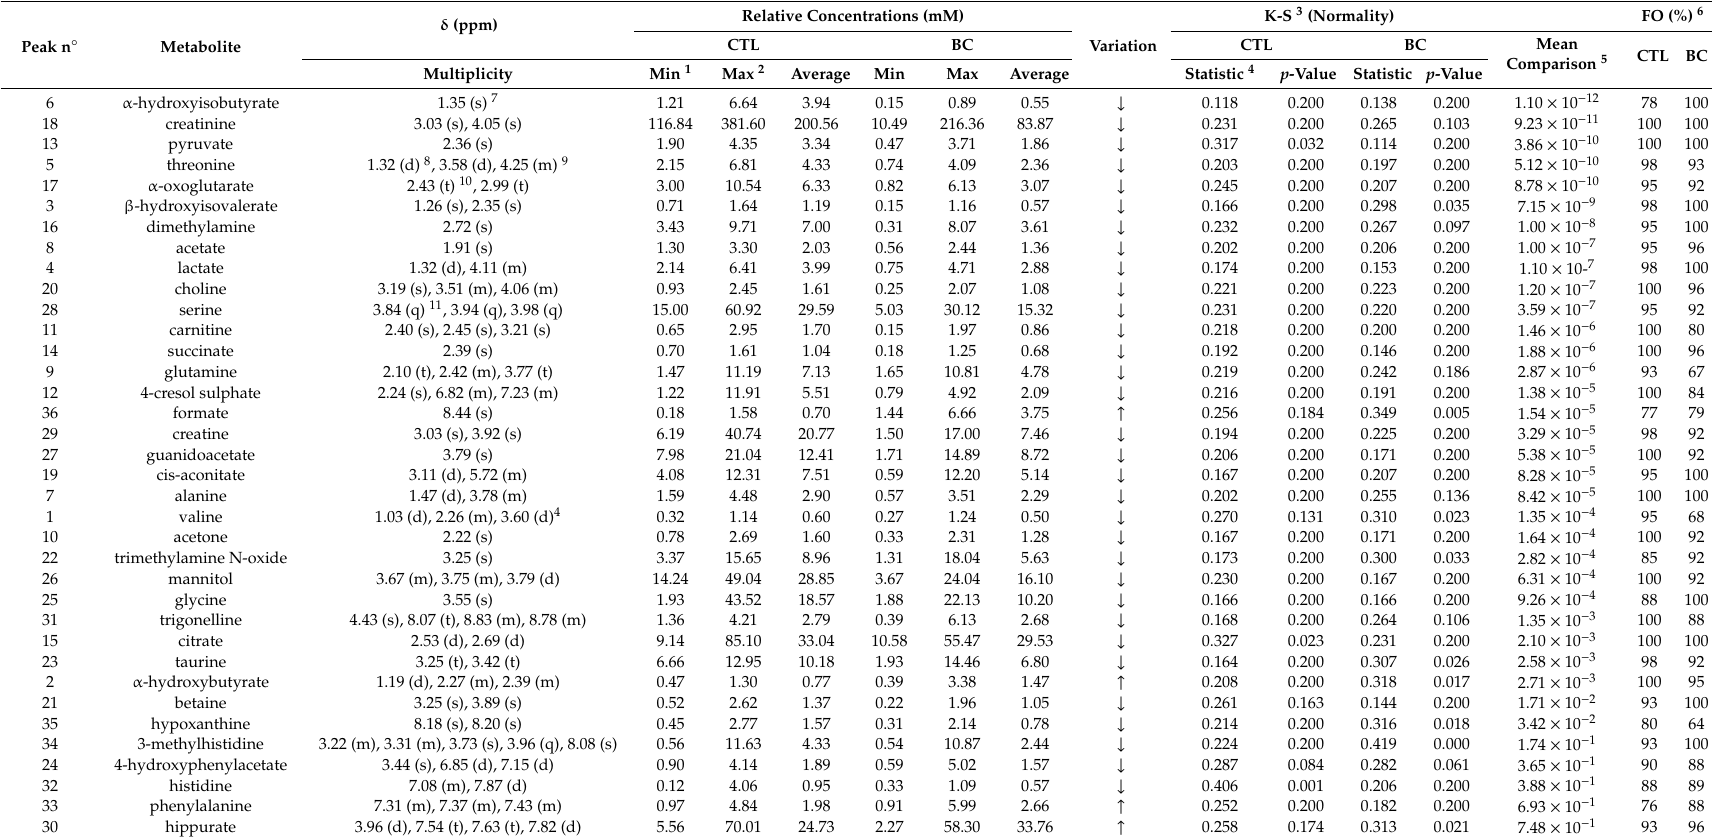
Table 2. Metabolites found in urine samples from breast cancer (BC) patients and healthy controls (CTL) ( n = 3, % RSD <